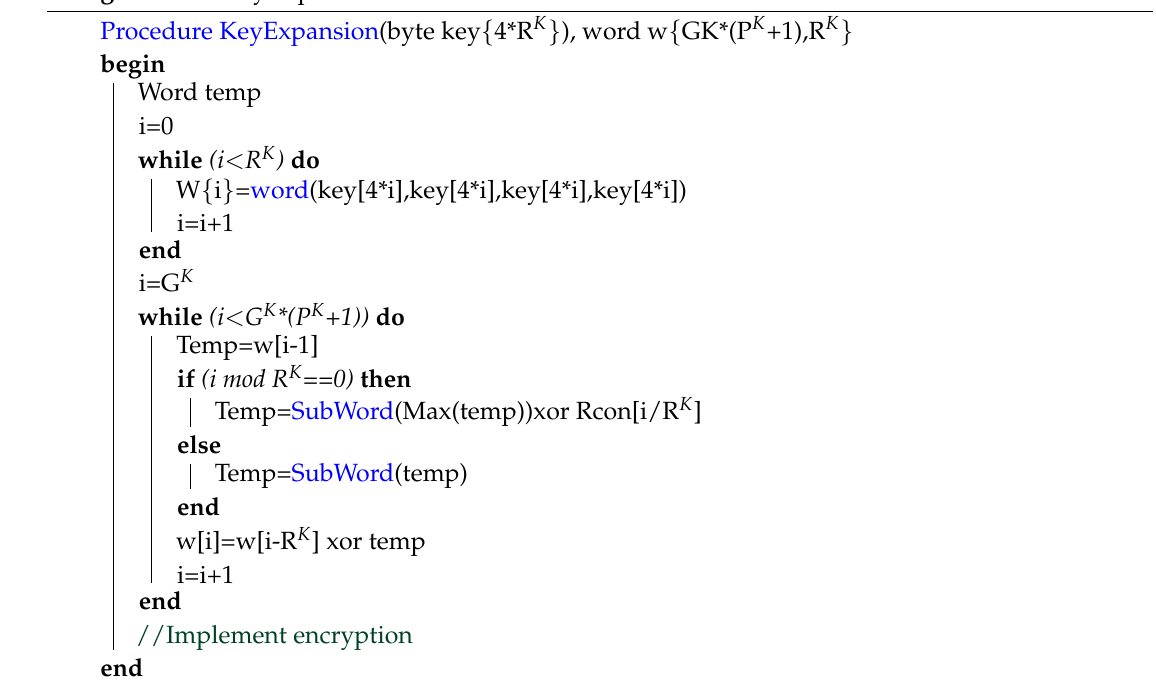
Algorithm 2: Key expansion